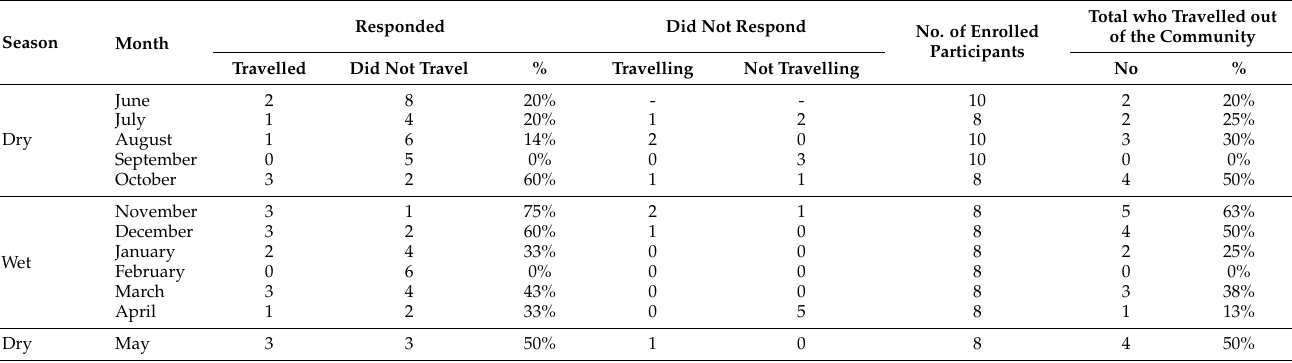
Table A4. Travel out of the community by month.